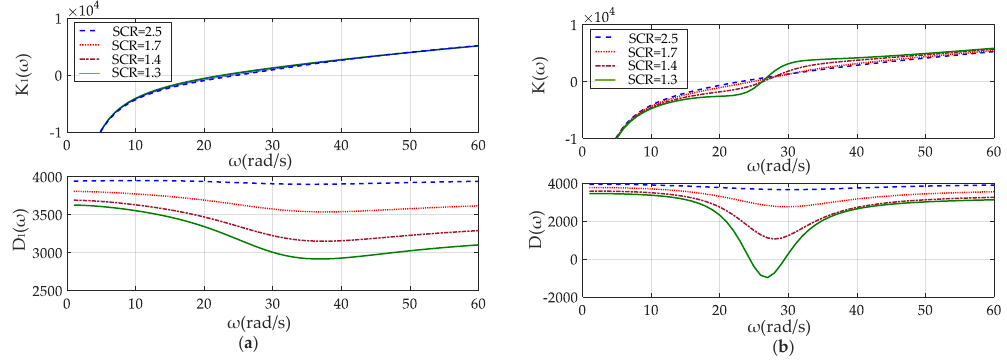
Figure 7. Frequency response curves of spring and damping coefficients under different grid strengths for ( a ) individual VSC1, ( b ) the entire system.